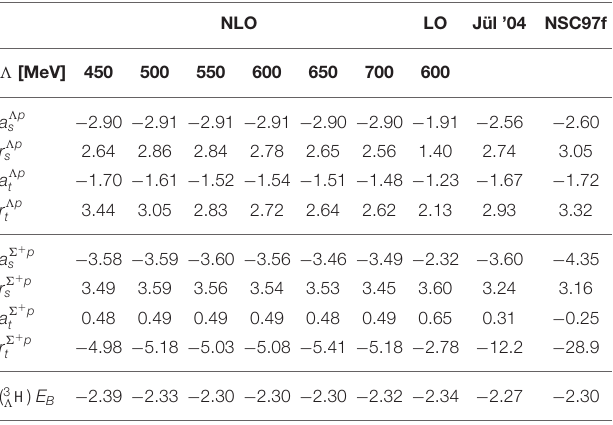
TABLE 5 | The YN singlet ( s ) and triplet ( t ) scattering length a and effective range r (in fm) and the hypertriton binding energy E B (in MeV) [33]. NLO LO Jül ’04